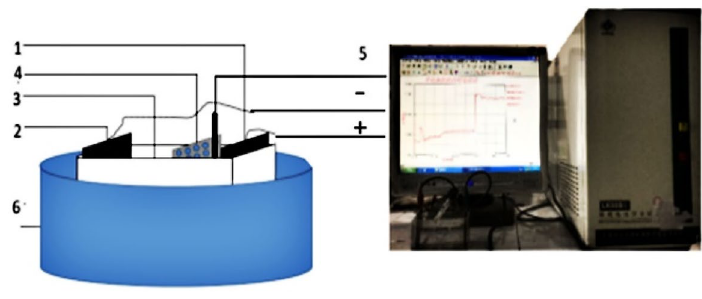
Figure 1. Diagram of the electrolytic reaction device. Anode plate 2-Cathode plate 3-Electrolytic cell 4-ion exchange membrane. 5-Reference electrode 6-Constant temperature water